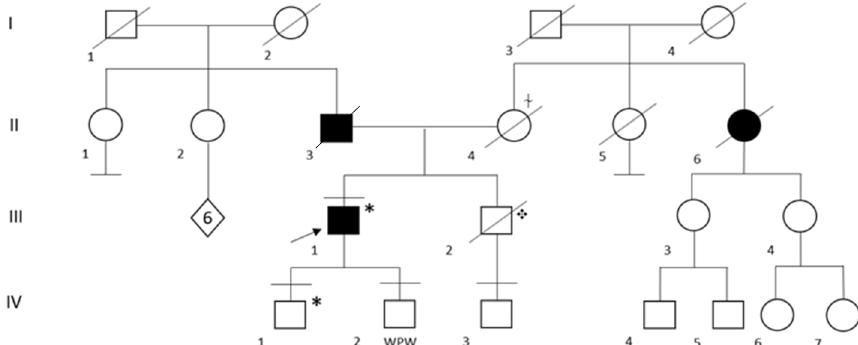
Figure 1. Family Pedigree of Patient ID 2. Black circle and squares indicate individuals with a clinical diagnosis of dilated cardiomyopathy. Black arrow indicates the proband. Black lines at the top indicate individuals who underwent to genetic testing. Black lines at the bottom indicate individuals without offspring. WPW: Wolf Parkinson White syndrome, ✥ Sudden Cardiac Death (SCD) at the age of 51 years. * Q833X heterozygous carrier, ⍭ Aortic dissection.